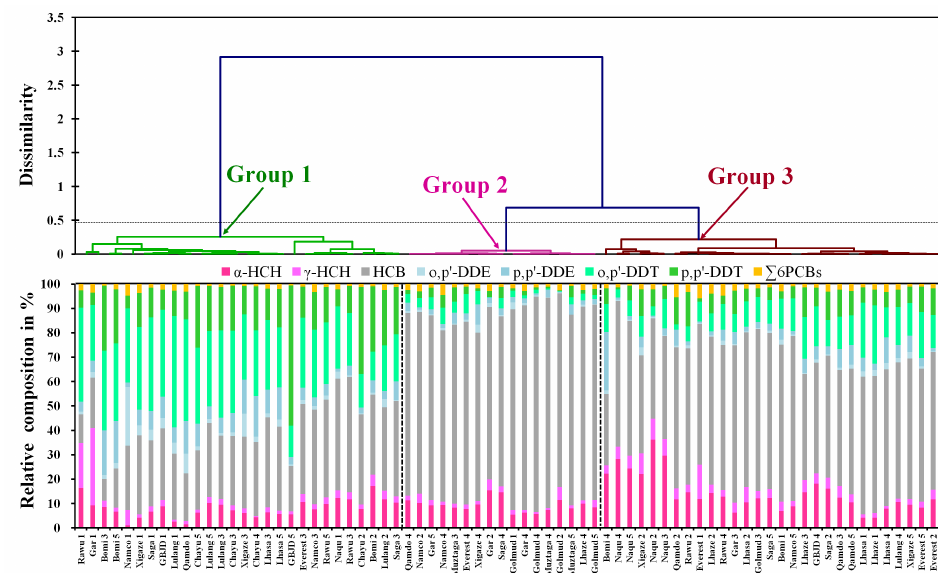
Figure 5. Dendrograph obtained by the cluster analysis (above) and the corresponding relative composition plot (bottom). The dendrogram includes a horizontal dashed line indicating where the number of clusters is stable, because moving up and down of this line along the similarity axis, the number of groups did not change. Samples in the composition plot were named by the name of sampling site and the Arabic numbers 1–5, which represent the sampling year from 2007 to 2012. For example, the first sampling year (from 2007 to 2008) is numbered as 1, and the second year (from 2008 to 2009) is numbered as 2, and so on.